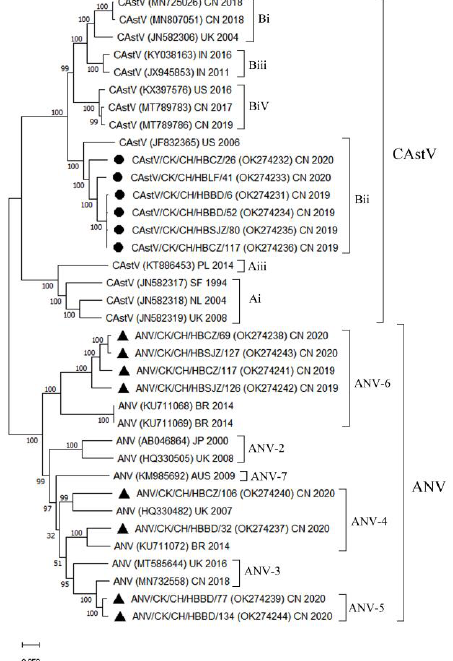
Figure 3. Phylogenetic tree based on analysis of open reading frame 2 (ORF2) complete gene of chicken astrovirus (CAstV) strains and avian nephritis virus (ANV) strains. Molecular Genetics Evo- lutionary Analysis version 11 was used for phylogenetic tree reconstruction using the neighbor- joining algorithm with 1000 bootstrap replicates. These included sequences of different